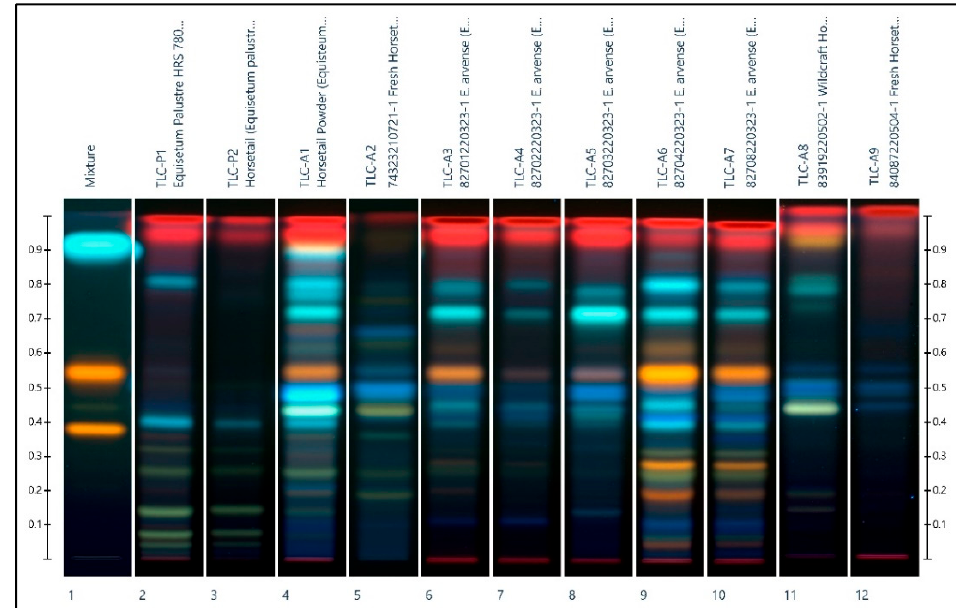
Figure 2. HPTLC chromatogram showing the E. arvense extracts of A1 to A9 (tracks 4 to 12). The E. palustre extracts of P1 and P2 (tracks 2 and 3, respectively) are also shown for comparison. The chemical standards rutin, hyperoside, and caffeic acid are present in ascending order on track 1.